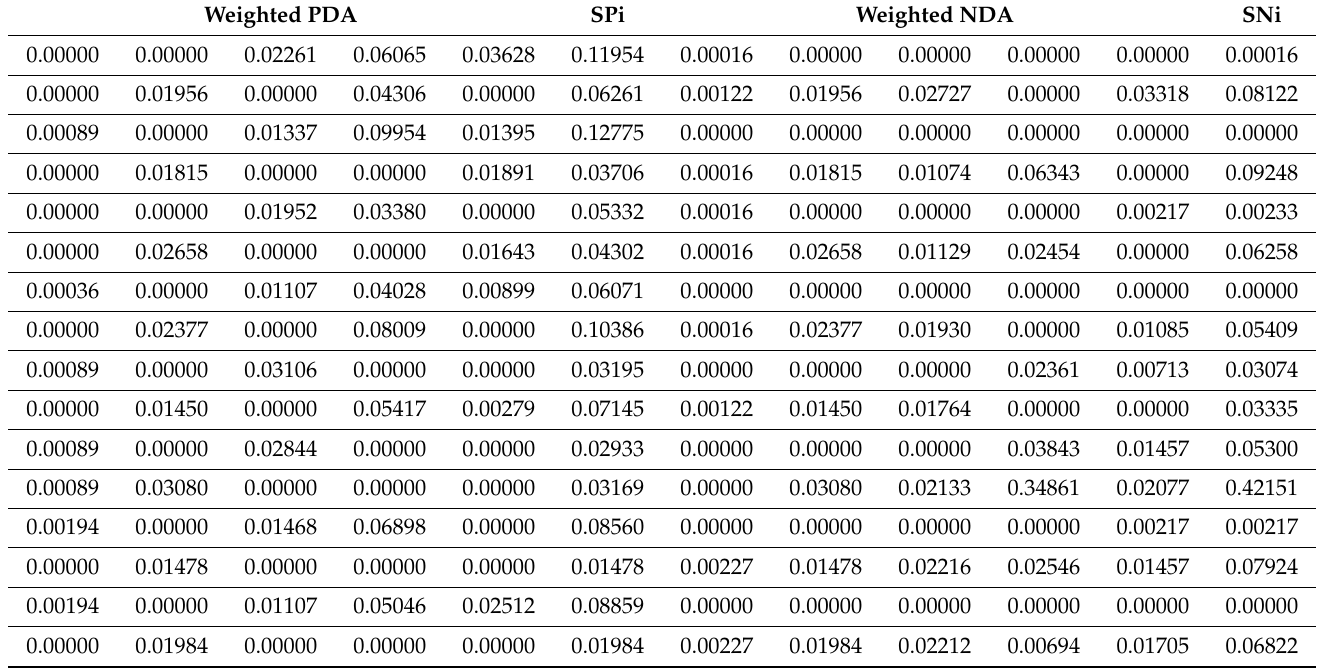
Table 10. Computation of Weighted PDA, NDA, SPi and